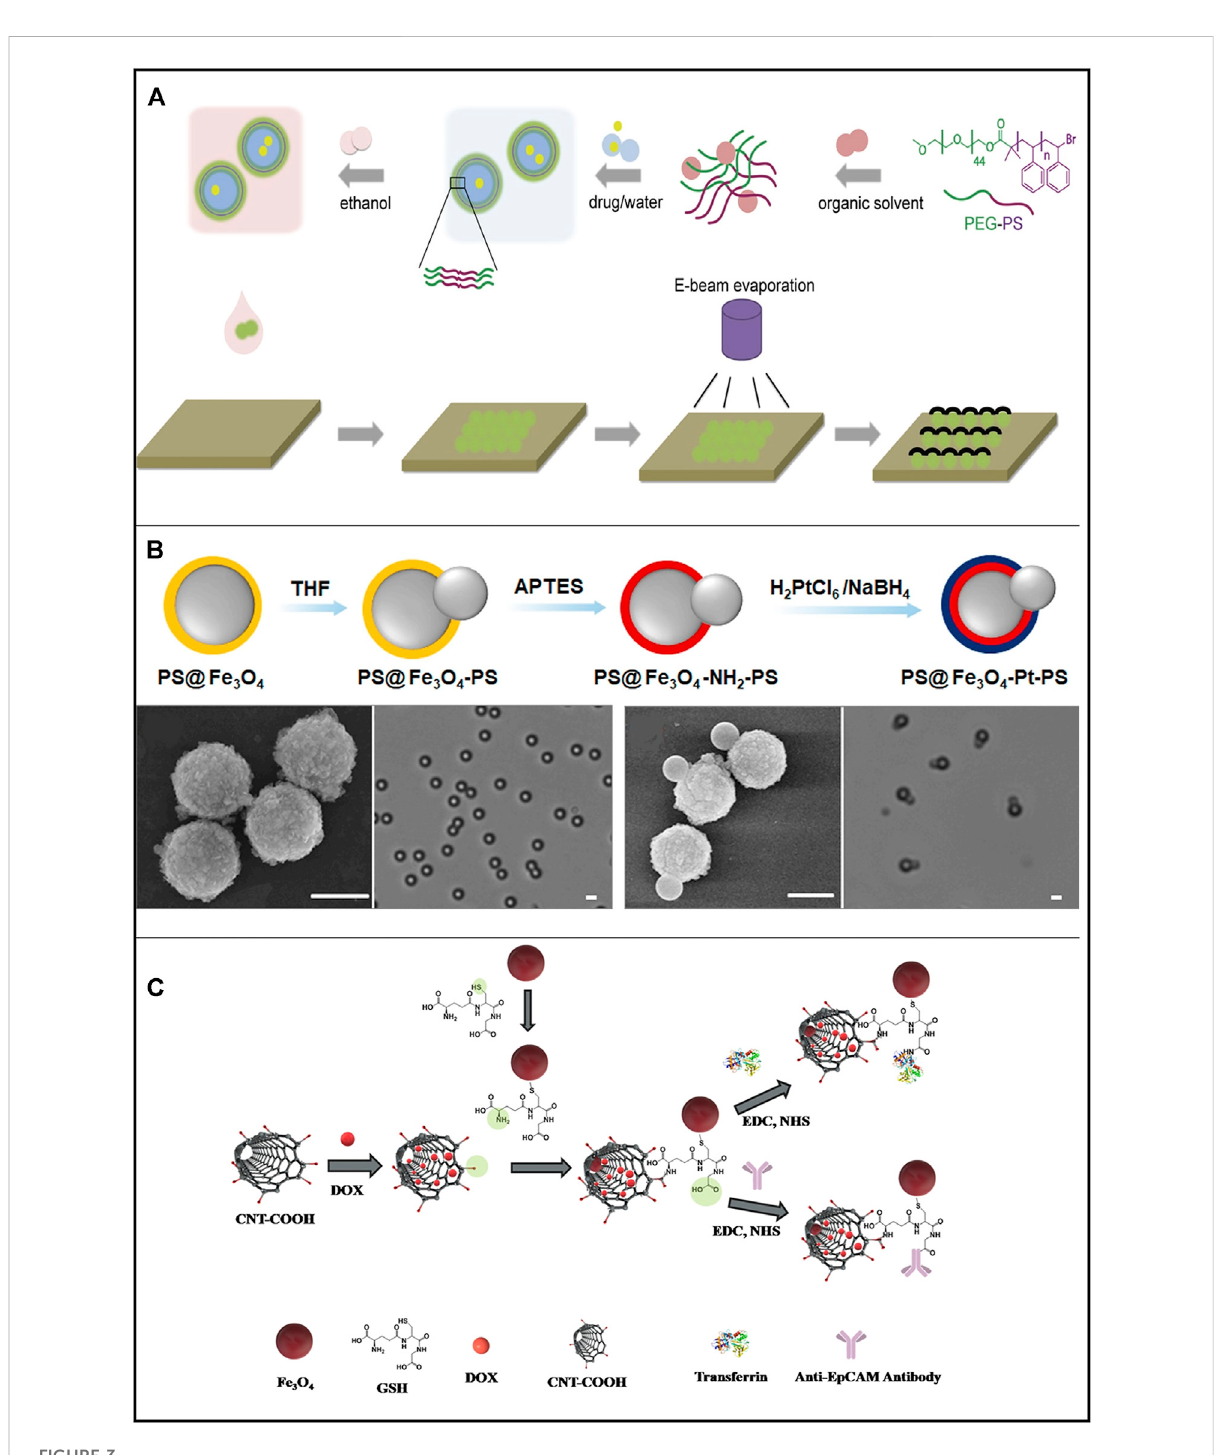
FIGURE 3 Motile drug delivery by peroxide-powered MNRs. (A) Poly (ethylene glycol)-b-polystyrene (PEG-PS) polymersome-based Janus nanomotors. (Peng et al., 2018) Copyright 2018. Reproduced with permission from John Wiley and Sons. (B) Dual-drive hybrid micromotors (PS@Fe 3 O 4 @Pt-PS). (Chen et al., 2020)Copyright 2020. Reproduced with permission from Elsevier Inc. (C) Multi-component magnetic nanobot designed by